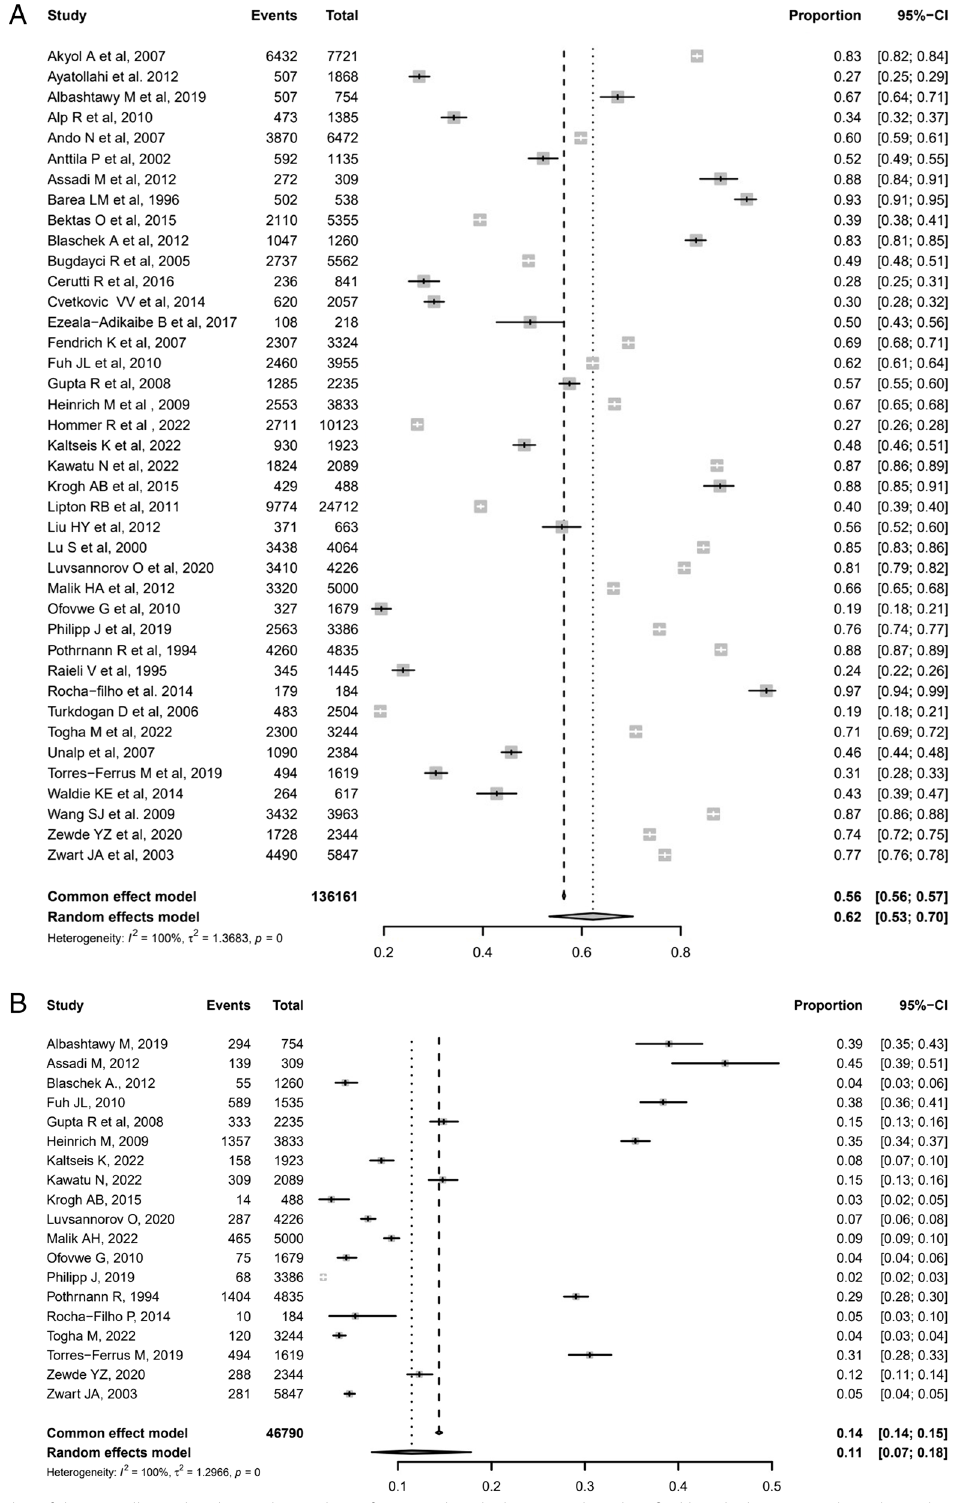
Fig. 5 Forest plot of the overall weighted prevalence data of primary headache ( A ) and unclassified headache ( B ). Total: total population sample; Events: number of primary headache diagnosis; CI: Confidence